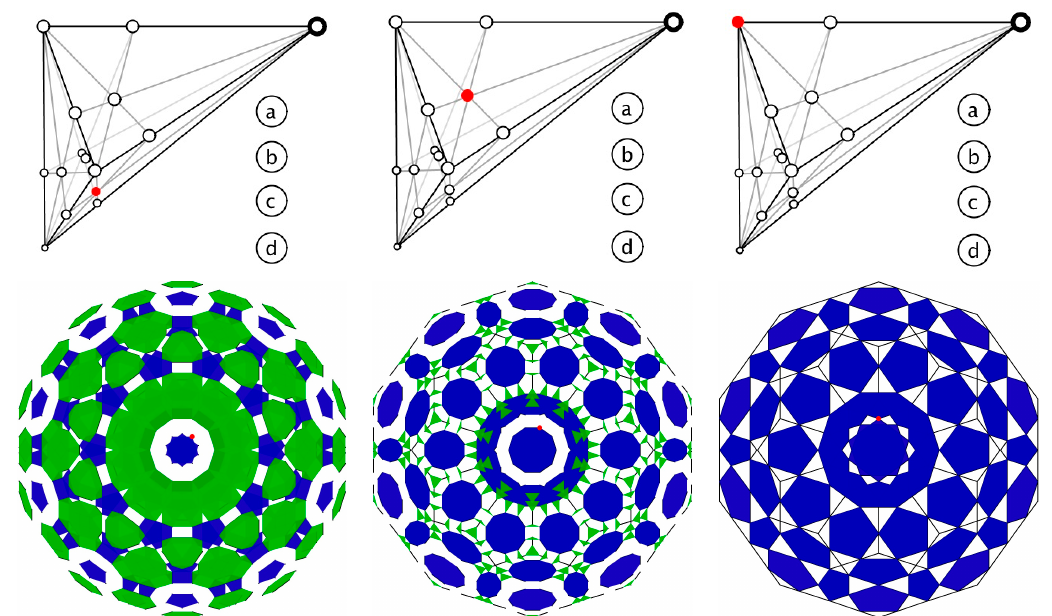
Figure 5. Three examples of focal points of an object being selected within the shape parameter map in the Context Panel. The selected focal point is encoded as a red dot. Each object underneath the map is the resulting view from the selected focal point.